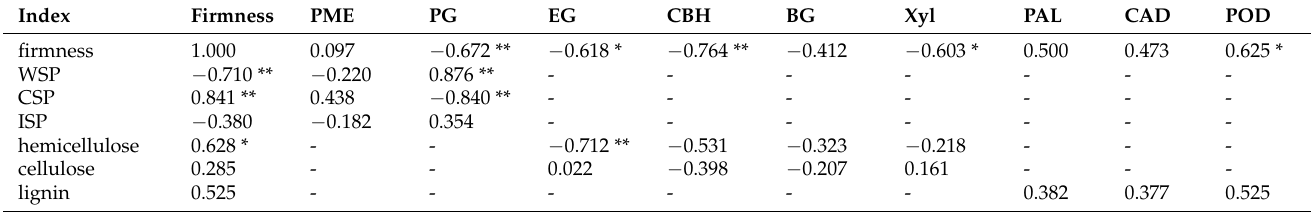
Table 2. Correlations between the cell wall components and the cell wall-degrading enzyme